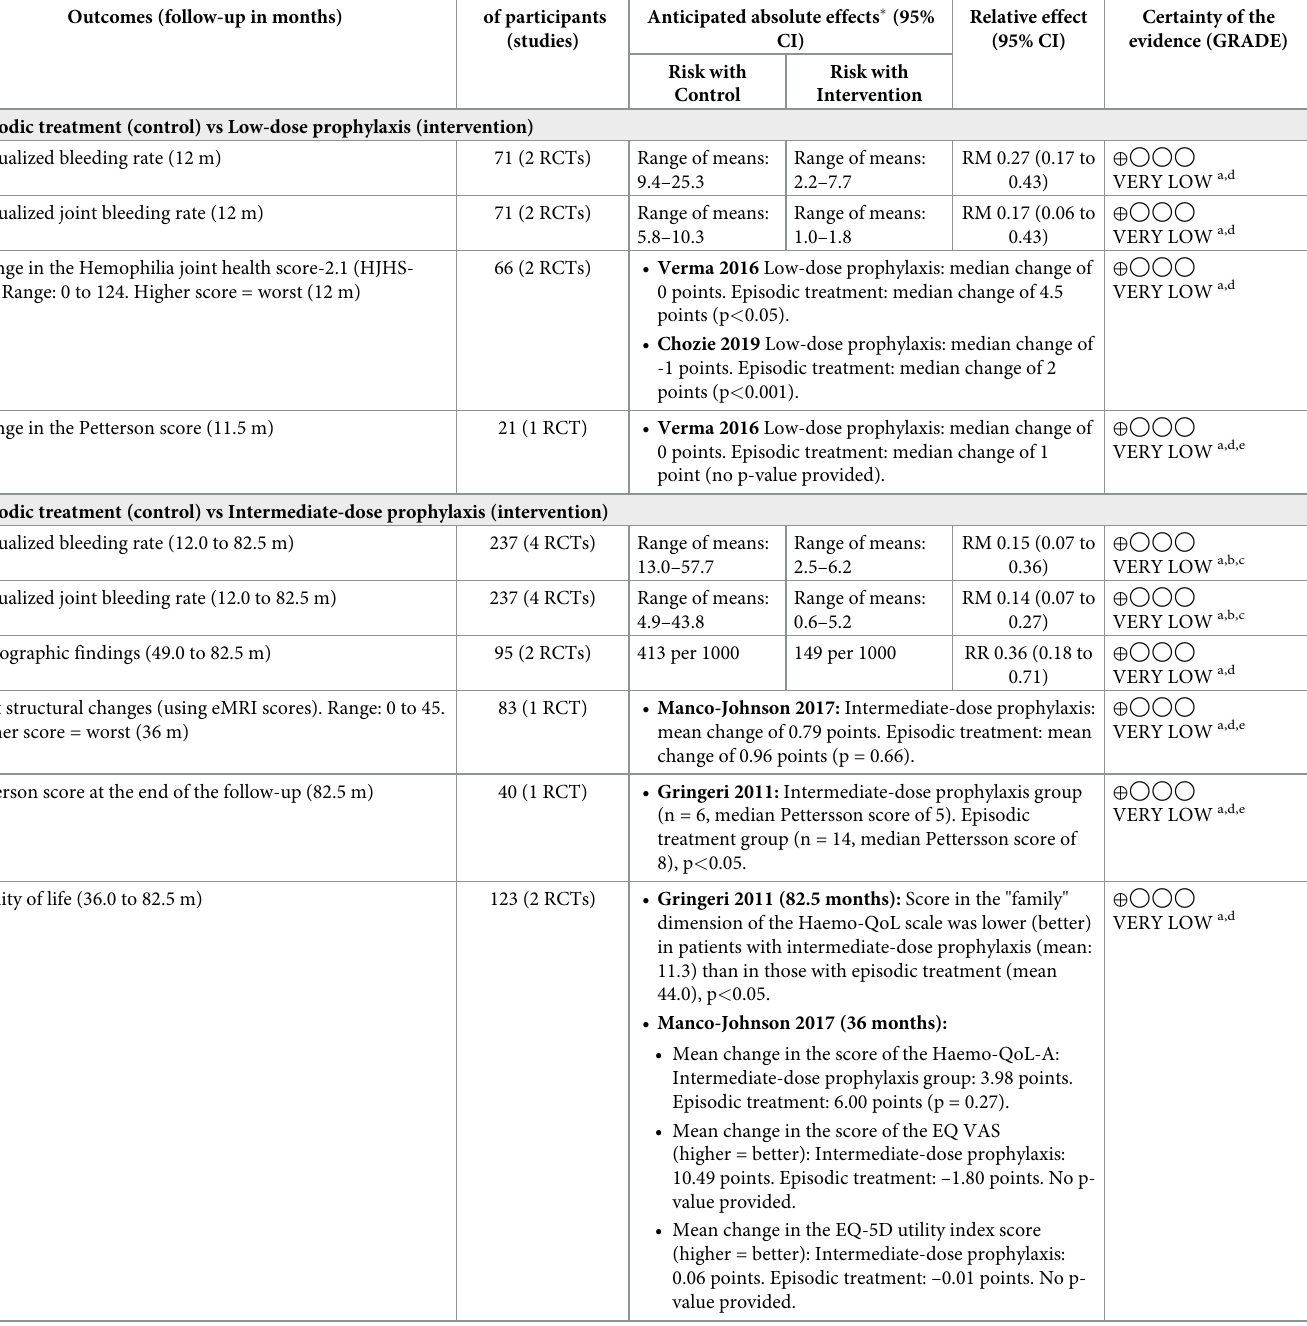
Table 2. Summary of findings for episodic treatment vs prophylaxis (either low, intermediate, or high